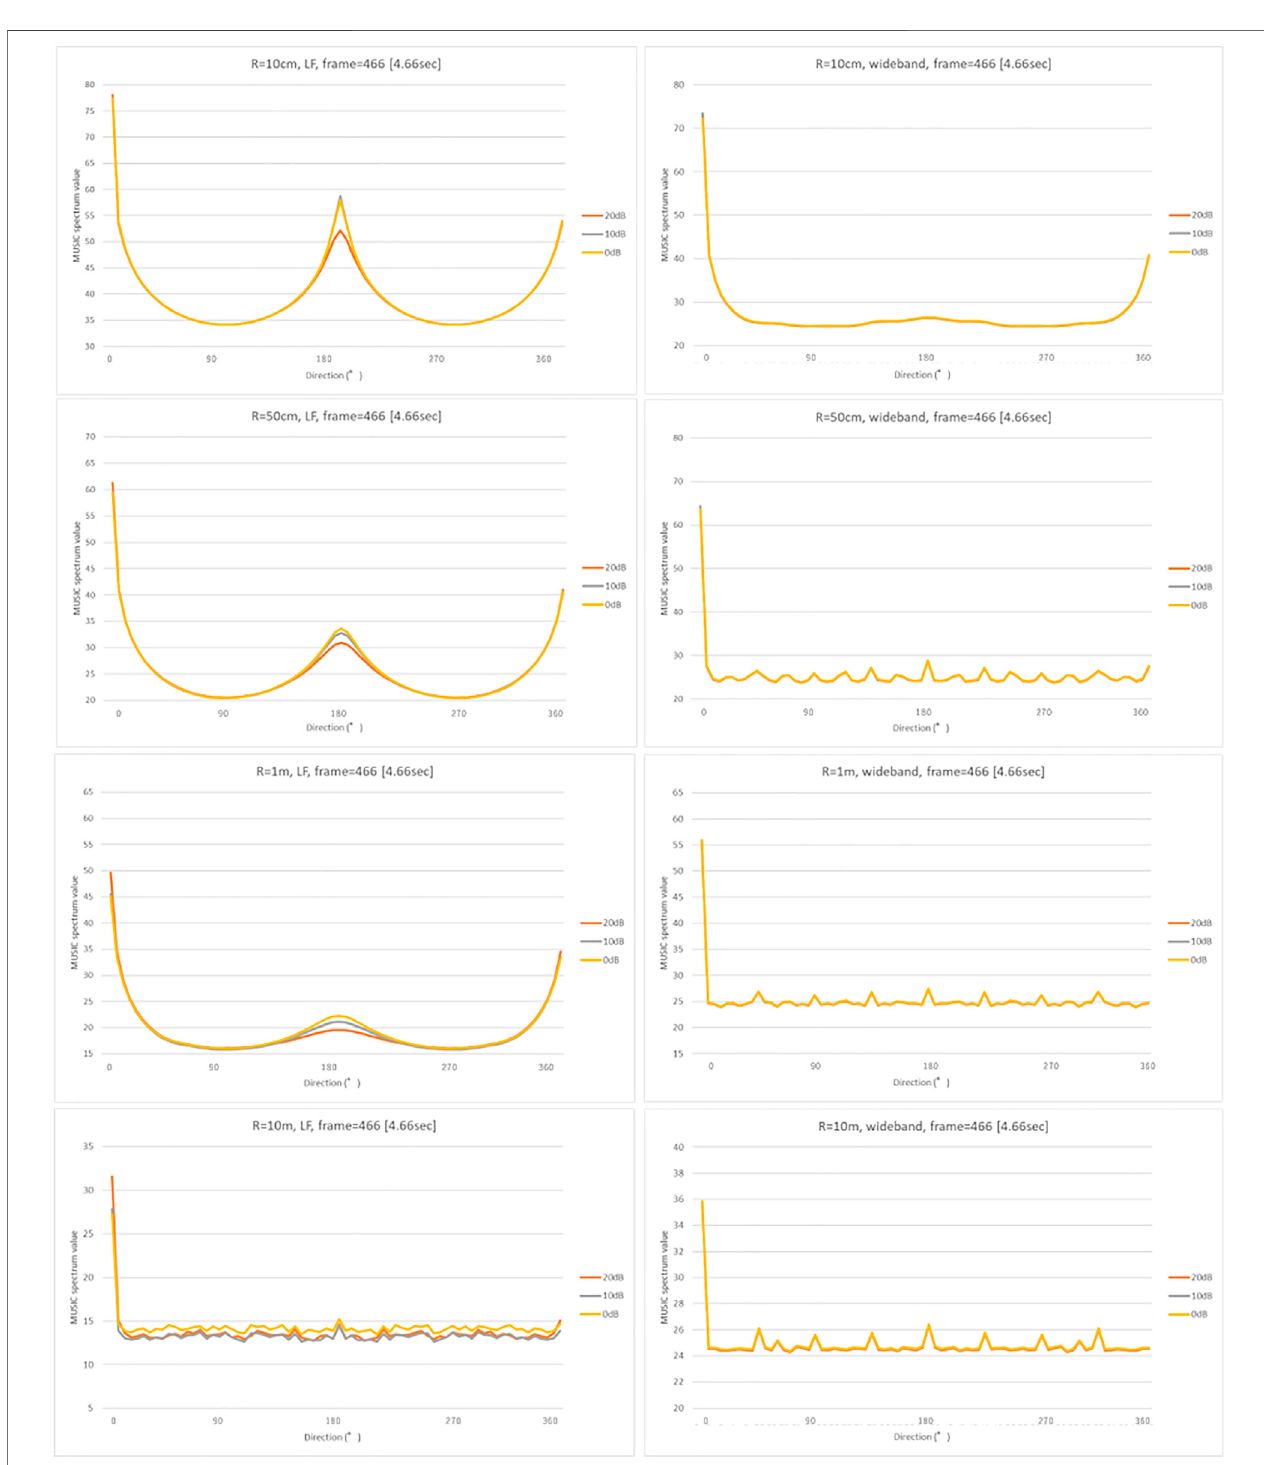
FIGURE 6 | MUSIC spatial spectrum for LB (left) and WB (right). The vertical and horizontal axes indicate the direction and MUSIC spatial spectrum value, respectively. The conditions of the 1 st -4 th subgraphs correspond to those of the 2 nd -5 th subgraphs in Figure 5 .